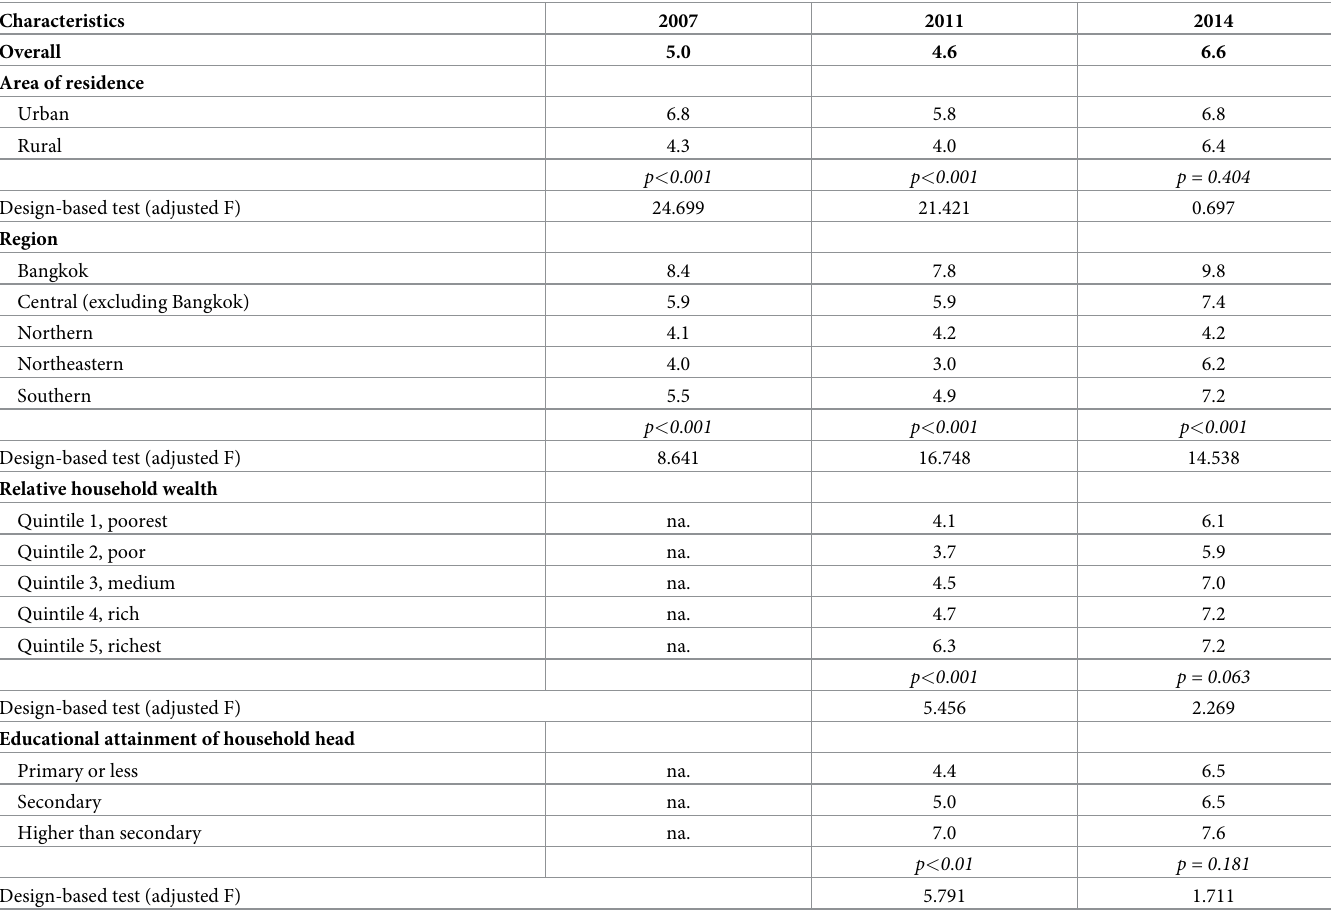
Table 1. Percentage of household need for caregivers of older persons by area of residence, region, relative household wealth, and educational attainment of house- hold head, 2007, 2011, and 2014.